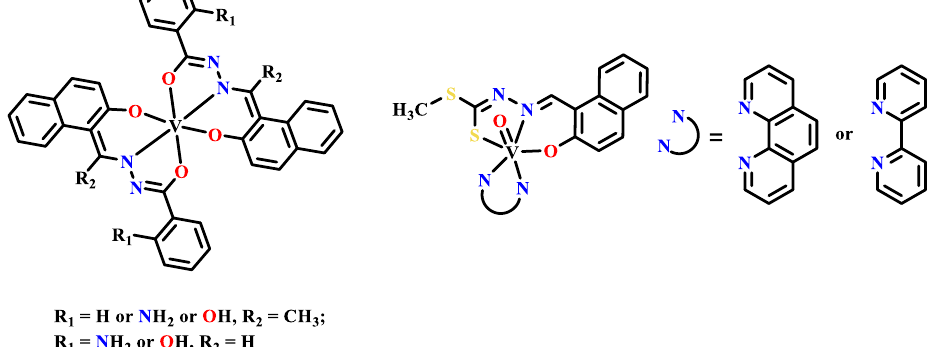
Figure 18. Several vanadium(IV) complexes reported by Rupam Dinda ’ s group.